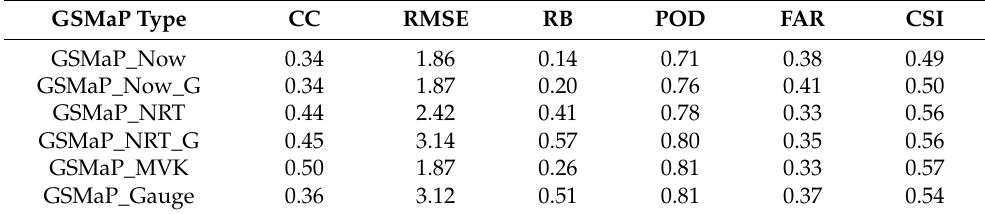
Table 6. The mean of validation data matrix for daily data for all